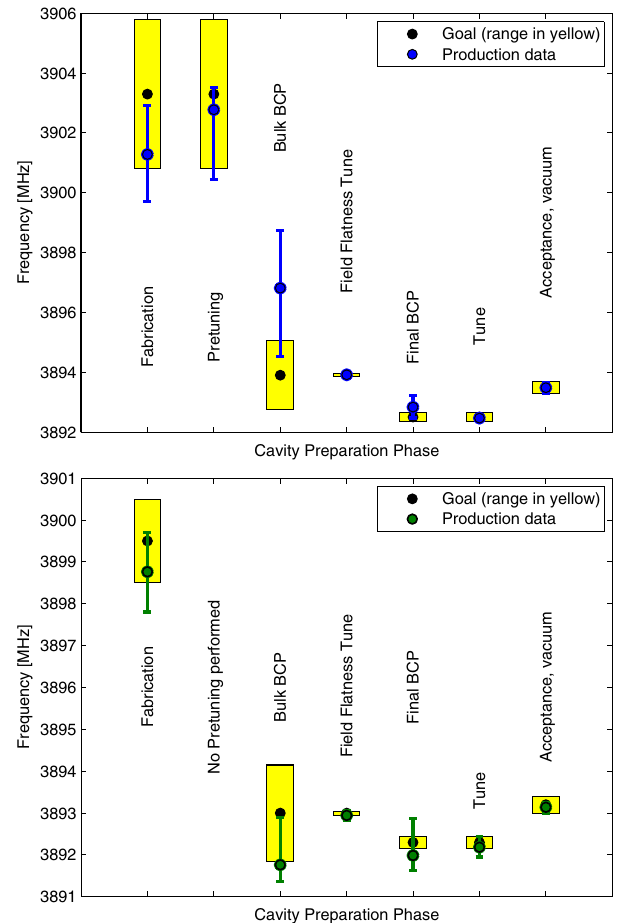
FIG. 3. Frequency ranges foreseen in the cavity preparation sequence (black dots and yellow boxes) and measured data (with error bars) during the production of the first (above) and second (below) cavity batches. From the first to the second batch the frequency preparation goals were changed no pretuning was performed after the mechanical fabrication.